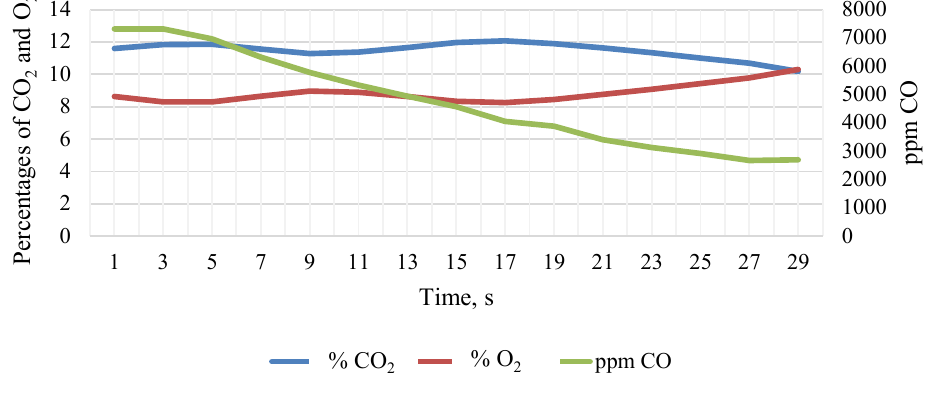
Fig. 7. Emissions Observation